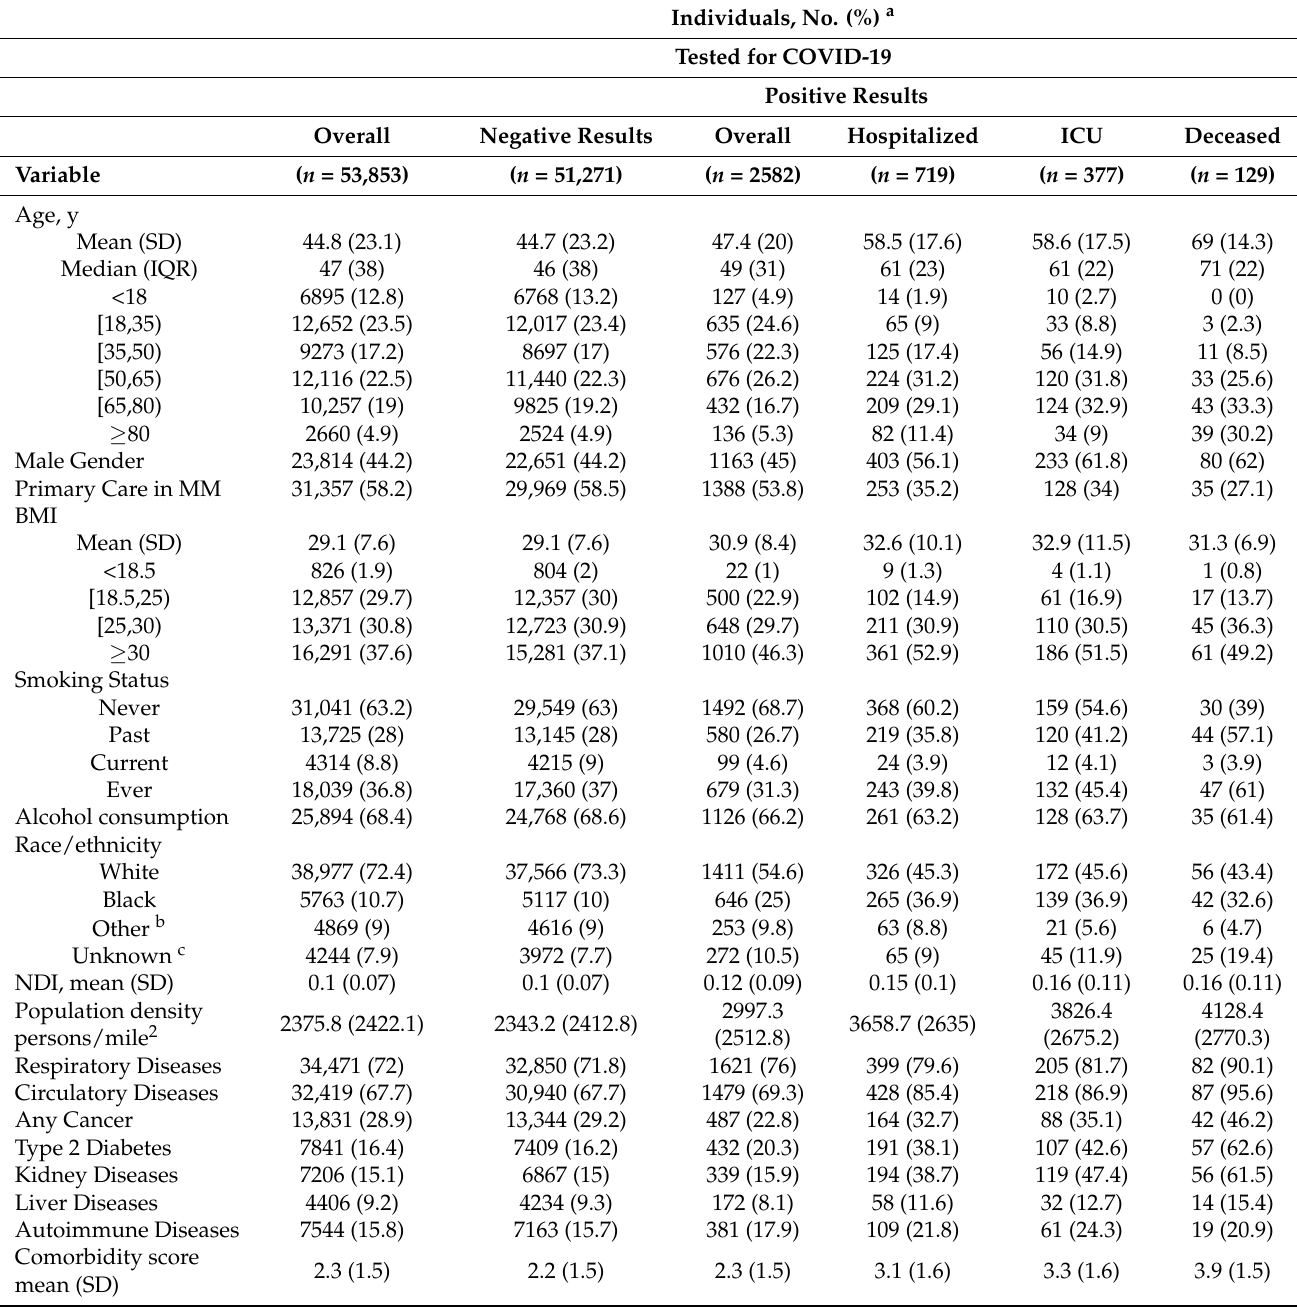
Table 1. Descriptive Characteristics of the COVID-19 Tested/Diagnosed cohort at Michigan Medicine (10 March–2 September 2020). Individuals, No. (%) a Tested for COVID-19 Positive Results Overall Negative Results Overall Hospitalized ICU